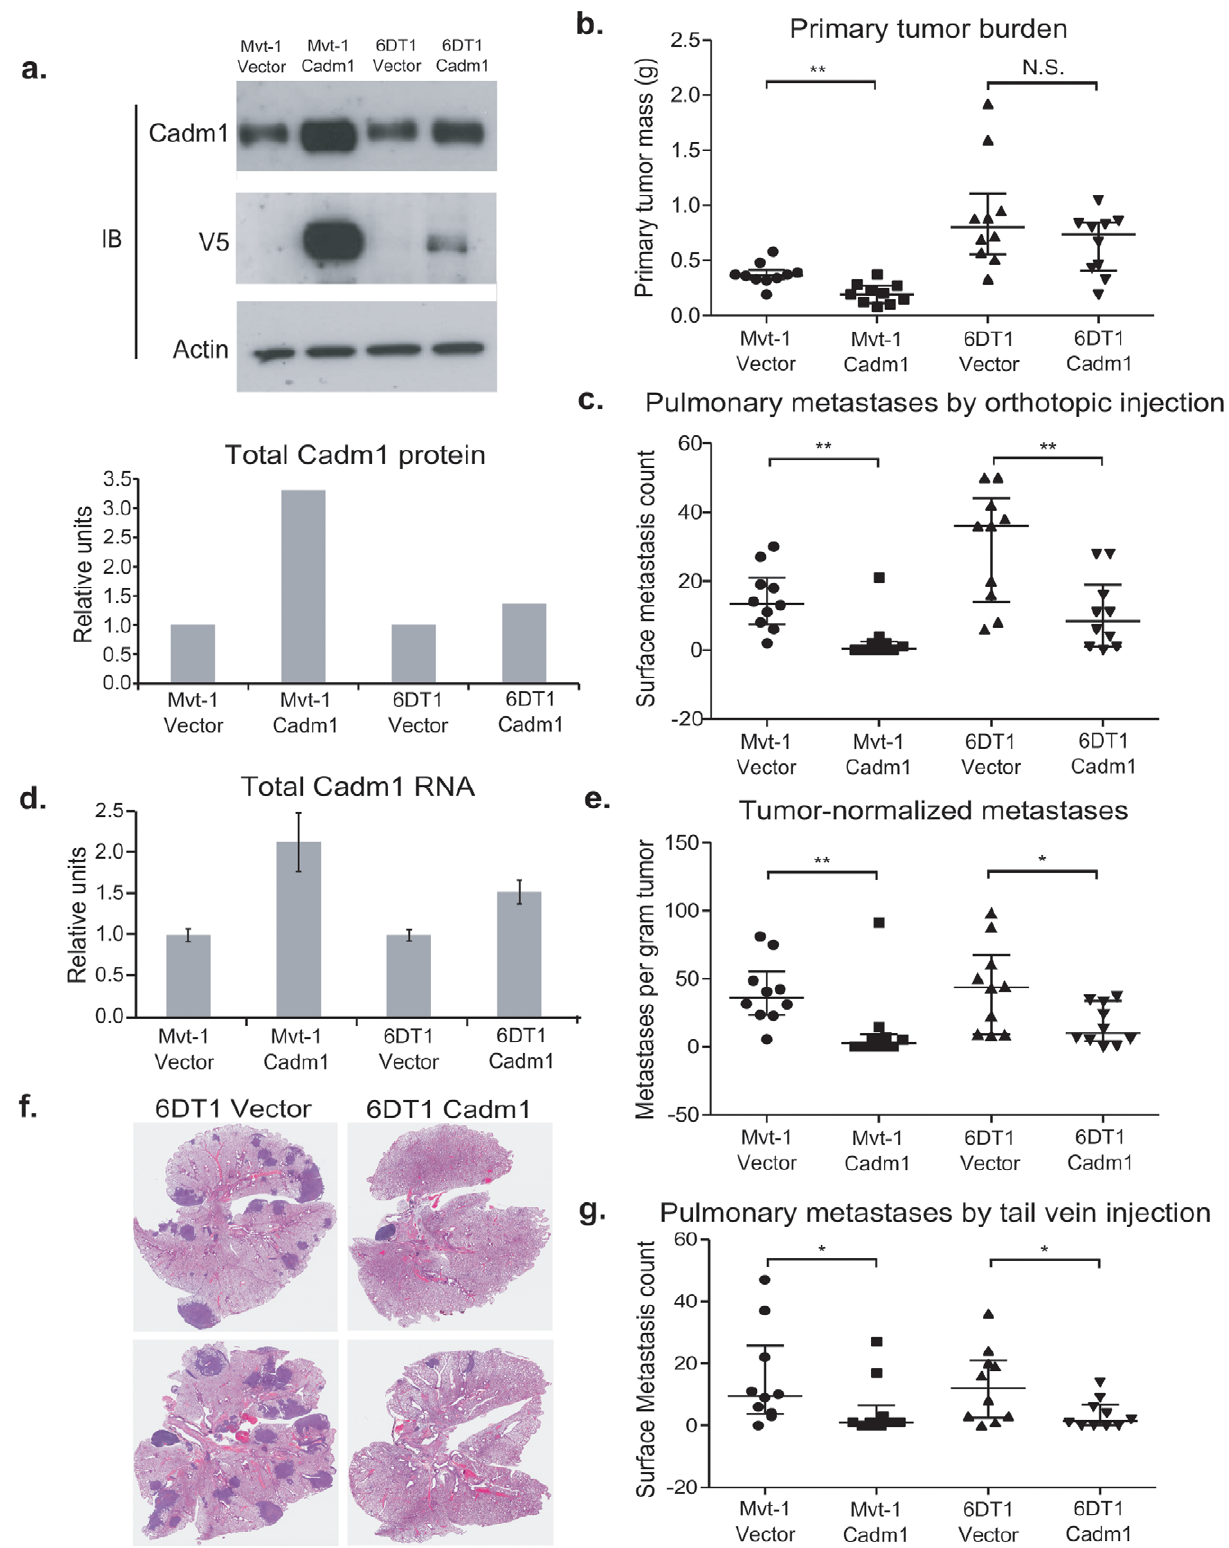
Figure 2. The effect of Cadm1 over-expression on tumor growth and metastasis invivo . (a) Expression of endogenous and exogenous V5- epitope tagged Cadm1 protein (IB, immunoblot) and total protein by ECL densitometry on immunoblot. (d) Total RNA levels of Cadm1 measured by qRT-PCR (mean + / 2 standard error of the mean [SEM]). Mvt-1 and 6DT1 mouse mammary tumor cells stably expressing Cadm1 were implanted into mammary fat pads of syngeneic FVB mice. Data on primary tumor burden (Mvt-1: p=0.0031; 6DT1: p=0.2261) (b), pulmonary surface metastases (c)